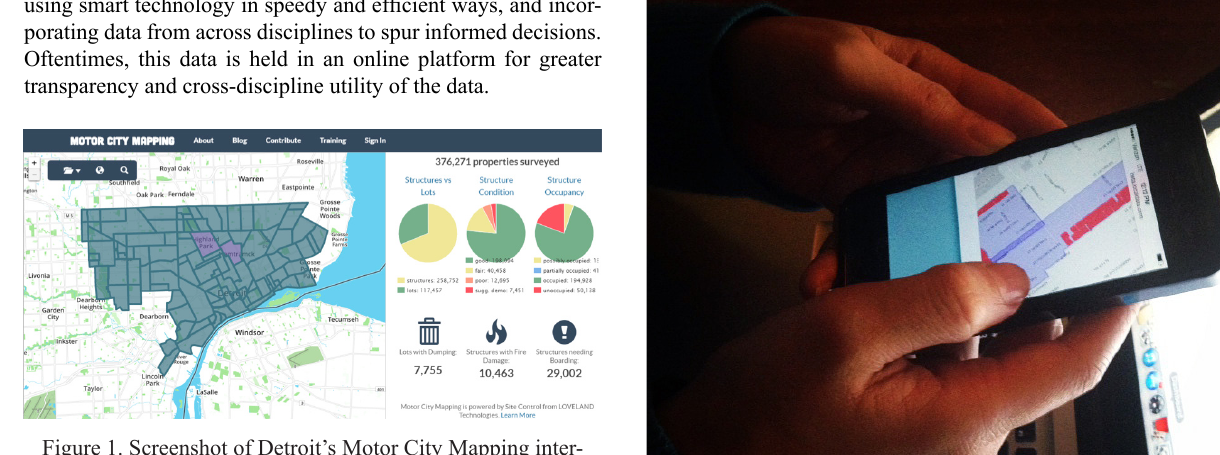
Figure 1. Screenshot of Detroit’s Motor City Mapping inter- active website, a result of the Data Driven Detroit initiative (Source: Motor City Mapping, 2017)